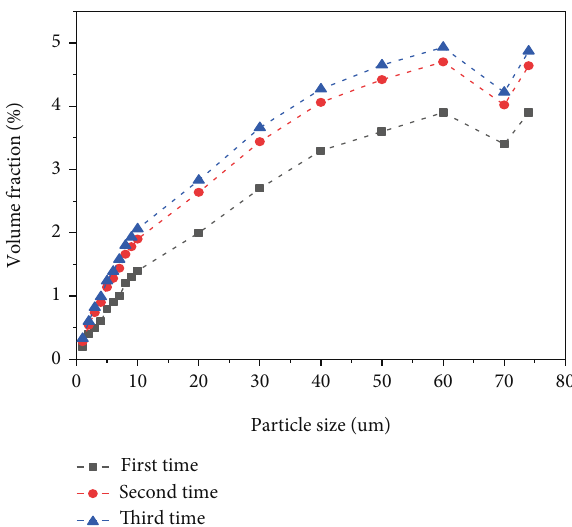
Figure 14: Variation of volume fraction under di ff erent intervals compared with original sample under